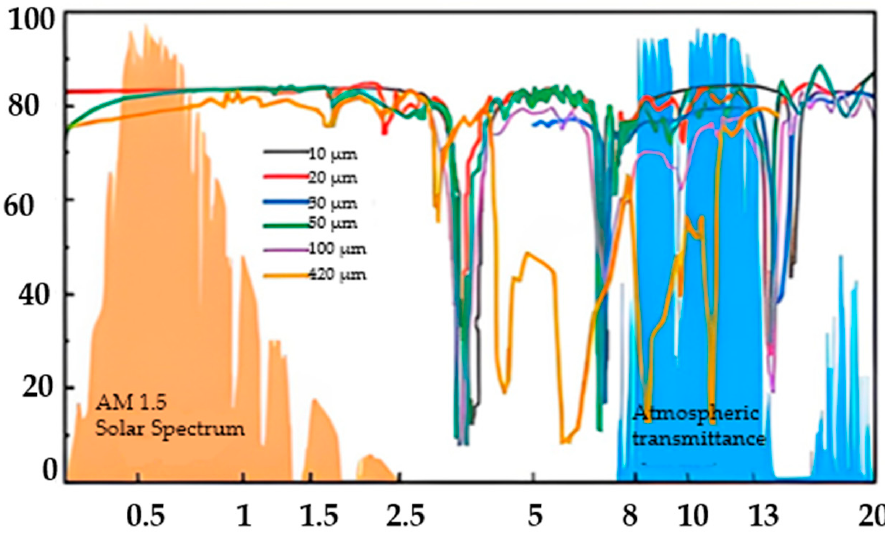
Figure 34. Full-length transmissivity spectrum of PE films at different thicknesses